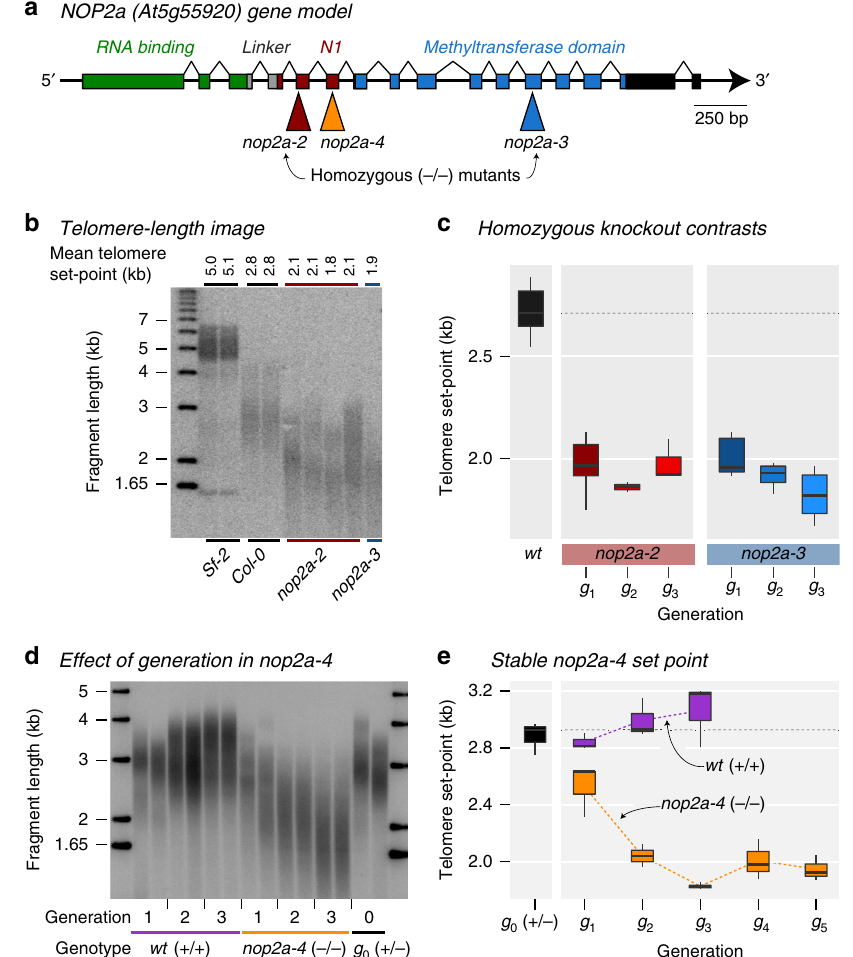
Fig. 3 Inactivation of AtNOP2A gene leads to the establishment of a new shorter telomere length set point. a Representation of the Arabidopsis NOP2A/ OLI2 gene model. Colored boxes represent exons; black lines, introns; and black boxes, untranslated regions. Positions of T-DNA insertion sites and the corresponding mutant line numbers are indicated. Predicted S-adenosyl- L -methionine-dependent methyltransferase functional domains are indicated on top. b A representative TRF southern blot for Sf-2 and Col-0 wild types and two NOP2A/OLI2 homozygous T-DNA mutant lines ( nop2a-2 and nop2a-3 ) is shown, where mean telomere length (mean TRF) for each individual analyzed plant is indicated at the top. Molecular weight DNA markers (in kb) are shown on the left. c The distributions of telomere length in ≥ 3 biological replicates of the Col-0 wild type and the two homozygous mutants are shown in boxplots (midline = median, box = interquartile range (IQR), whiskers = 1.5*IQR). Across generations, T-DNA mutants show shorter telomere length set point than the corresponding wild type Col-0 genotype. d An example of a TRF southern blot for telomere length analysis of several consecutive generations of homozygous nop2a-4 − / − mutants. Seeds of a single self-pollinated heterozygous nop2a-4 + / − plant were grown to identify wild type, heterozygous and homozygous G1 progeny, which were then used to generate corresponding G2 and G3 mutant generations by single seed descent. e , T-DNA mutants with the null nop2a-4 allele displayed signi fi cantly shorter telomeres after only a single generation of self-pollination, but established a new stable set point by the third generation of genetic screen for OLIGOCELLULA cell proliferation mutants ribosomal proteins identi fi ed in the OLIGOCELLULA cell pro- together with two other genes involved in rRNA binding and liferation pathway (NOP2A/OLI2, RPL5A/OLI5 and RPL5B/ ribosome biogenesis, OLI5/RPL5A and OLI7/RPL5B 29,30 . Arabi- OLI7) control telomere length set point in Arabidopsis. dopsis interactome data indicate that NOP2A physically interacts with RPL5A and RPL5B proteins (Fig. 4a). RPL5A and RPL5B encode highly conserved variants of ribosomal protein 5, an essential structural component of the large 60 S ribosomal sub- unit 35 . Human NOP2 and RPL5 proteins also interact 36 . Human RPL5 inhibits tumorigenesis, and its inactivation is the most common (11 – 34%) somatic ribosomal protein defect in multiple tumor types 37,38 . Similar to our analysis of Arabidopsis NOP2A/ OLI2 mutants, plants lacking RPL5A/OLI5 and RPL5B/OLI7 display a shorter telomere length set point that is within ( rpl5a / oli5-2 ) or close to ( rpl5b/oli7-2 ) the 1.8 – 2.0 kb length established in nop2a mutants (Fig. 4b – d). Thus, all of the